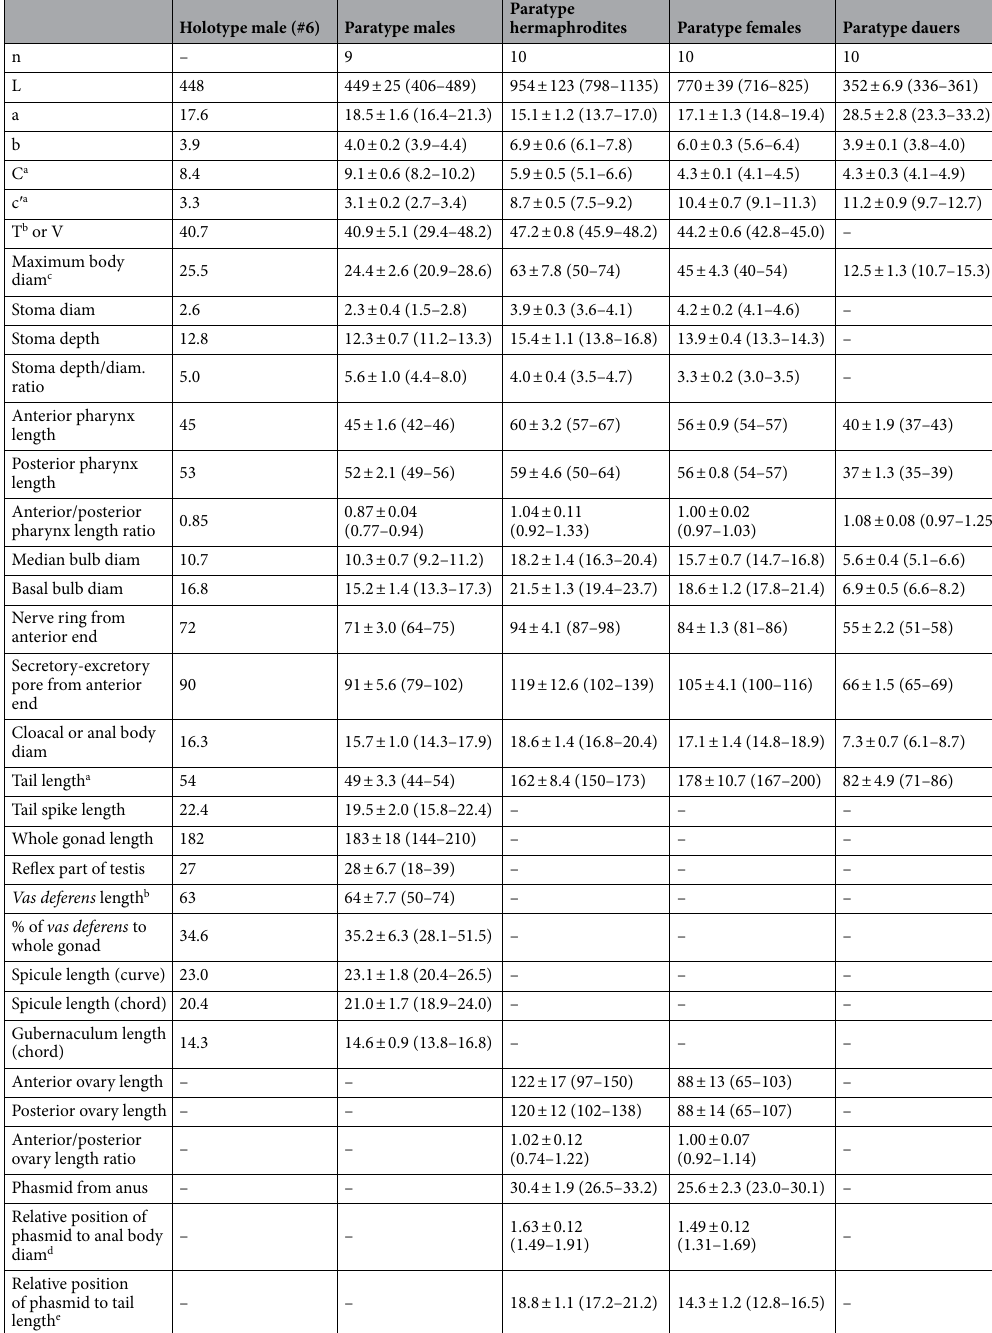
Table 2. Morphometric values for Tokorhabditis tufae n. gen., n. sp. a Tail length including tail spike. b Gonad length including reflex part and vas deferens. c Body diam. is maximum at vulval part in hermaphrodite and female (vulval body diam. = maximum body diam.). d Calculated as anus-phasmid distance/anal body diam. e Calculated as 100 × anus-phasmid distance/whole tail